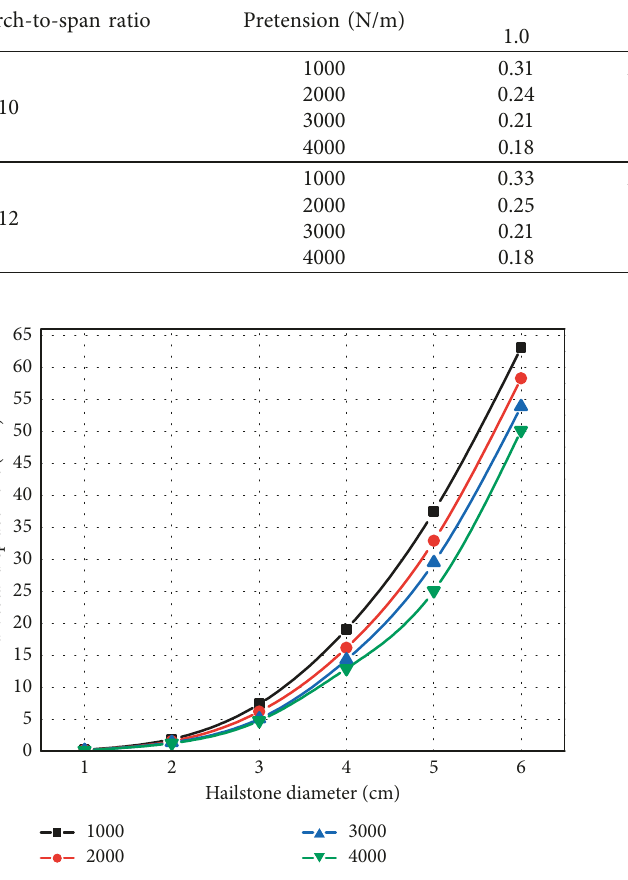
Figure 9: Total displacement curves of the impact point when arch- to-span ratio is 1/12 and the pretension levels increase from 1000 to 4000N/m.